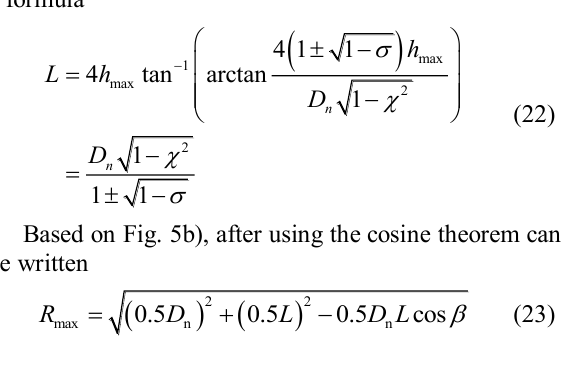
Fig. 6 . Diagram used to determine the basic parameters of the